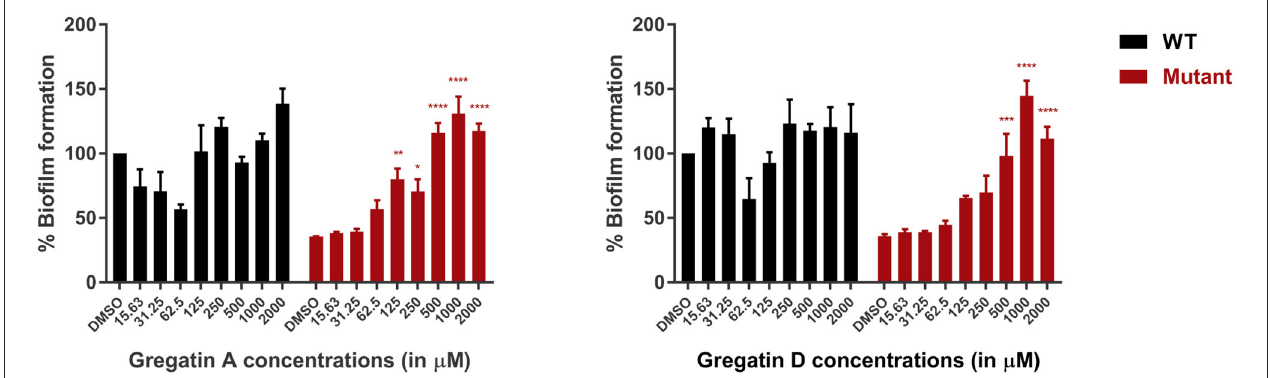
FIGURE 6 | The effect of the gregatins on biofilm formation in P. aeruginosa. Biofilm formation was measured by crystal violet staining after treatment with gregatin A and gregatin D and normalized to DMSO treated. The effect on biofilm formation in both WT and QS mutants ( 1 lasI / 1 rhlI ) was measured. The mean of three experiments performed in triplicates was plotted. The error bars represent the SEM. A one-way ANOVA, corrected for multiple comparisons with Dunnett’s test, was performed to determine statistical significance. Values are compared to DMSO-treated controls (* P < 0.05; ** P < 0.005; *** P < 0.001; **** P <